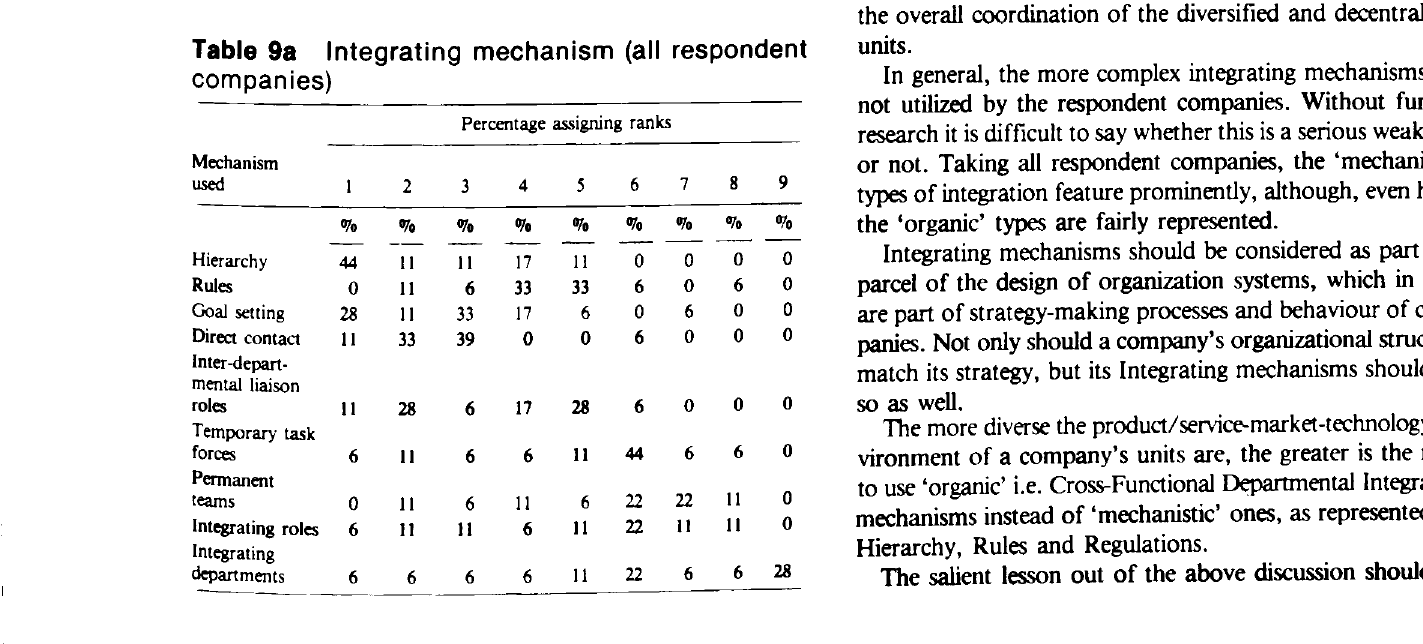
Integrating mechanism (all respondent